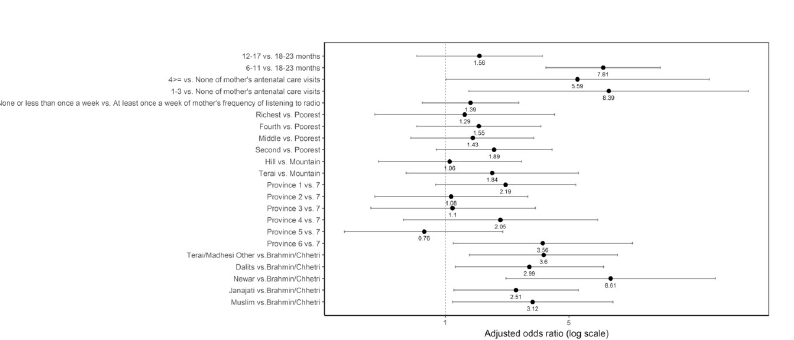
Fig 8. Percentage of Nepalese children aged 6 to 23 months meeting the minimum dietary diversity by sociodemographic factors.